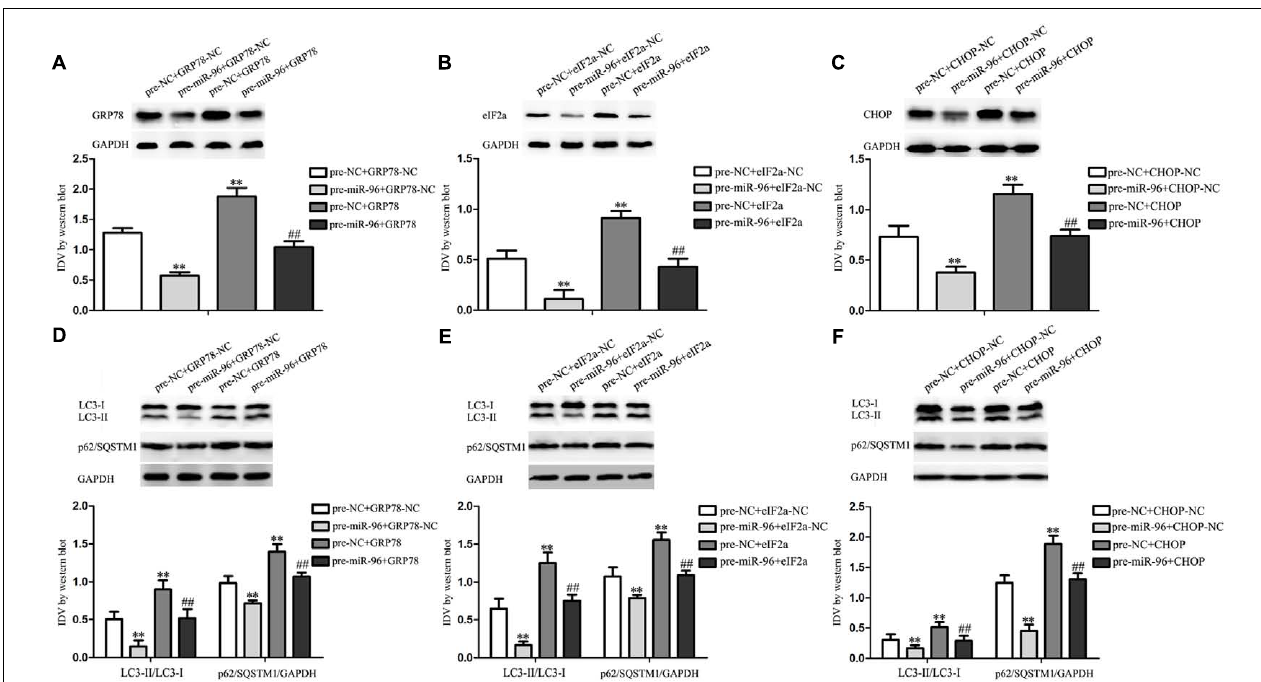
FIGURE 9 | Effect of miR-96 over-expression and UPR-related proteins (GRP78, eIF2 α , and CHOP) over-expression on the expression of LC3 and p62/SQSTM1 in GECs. (A–C) Western blot assay to evaluate the efficiency after miR-96 over-expression and/or GRP78 (or eIF2 α , CHOP) over-expression. (D) Western blot assay to evaluate the effect of miR-96 and GRP78 over-expression on the expression of LC3 and p62/SQSTM1 in GECs. Data represent means ± SD ( n = 5, each). ∗∗ P < 0.01 vs. pre-NC+GRP78-NC group, ## P < 0.01 vs. pre-miR-96+GRP78-NC group. (E) Western blot assay to evaluate the effect of miR-96 and eIF2 α over-expression on the expression of LC3 and p62/SQSTM1 in GECs. ∗∗ P < 0.01 vs. pre-NC+eIF2 α -NC group, ## P < 0.01 vs. pre-miR-96+eIF2 α -NC group. (F) Western blot assay to evaluate the effect of miR-96 and CHOP over-expression on the expression of LC3 and p62/SQSTM1 in GECs. ∗∗ P < 0.01